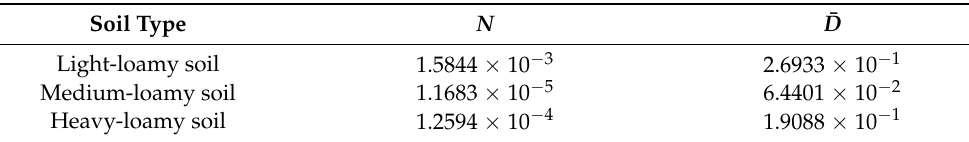
Figure 7. Schematic diagram of the boundary conditions for soil–water infiltration during application. Table 3. N and ¯ D values for different soil